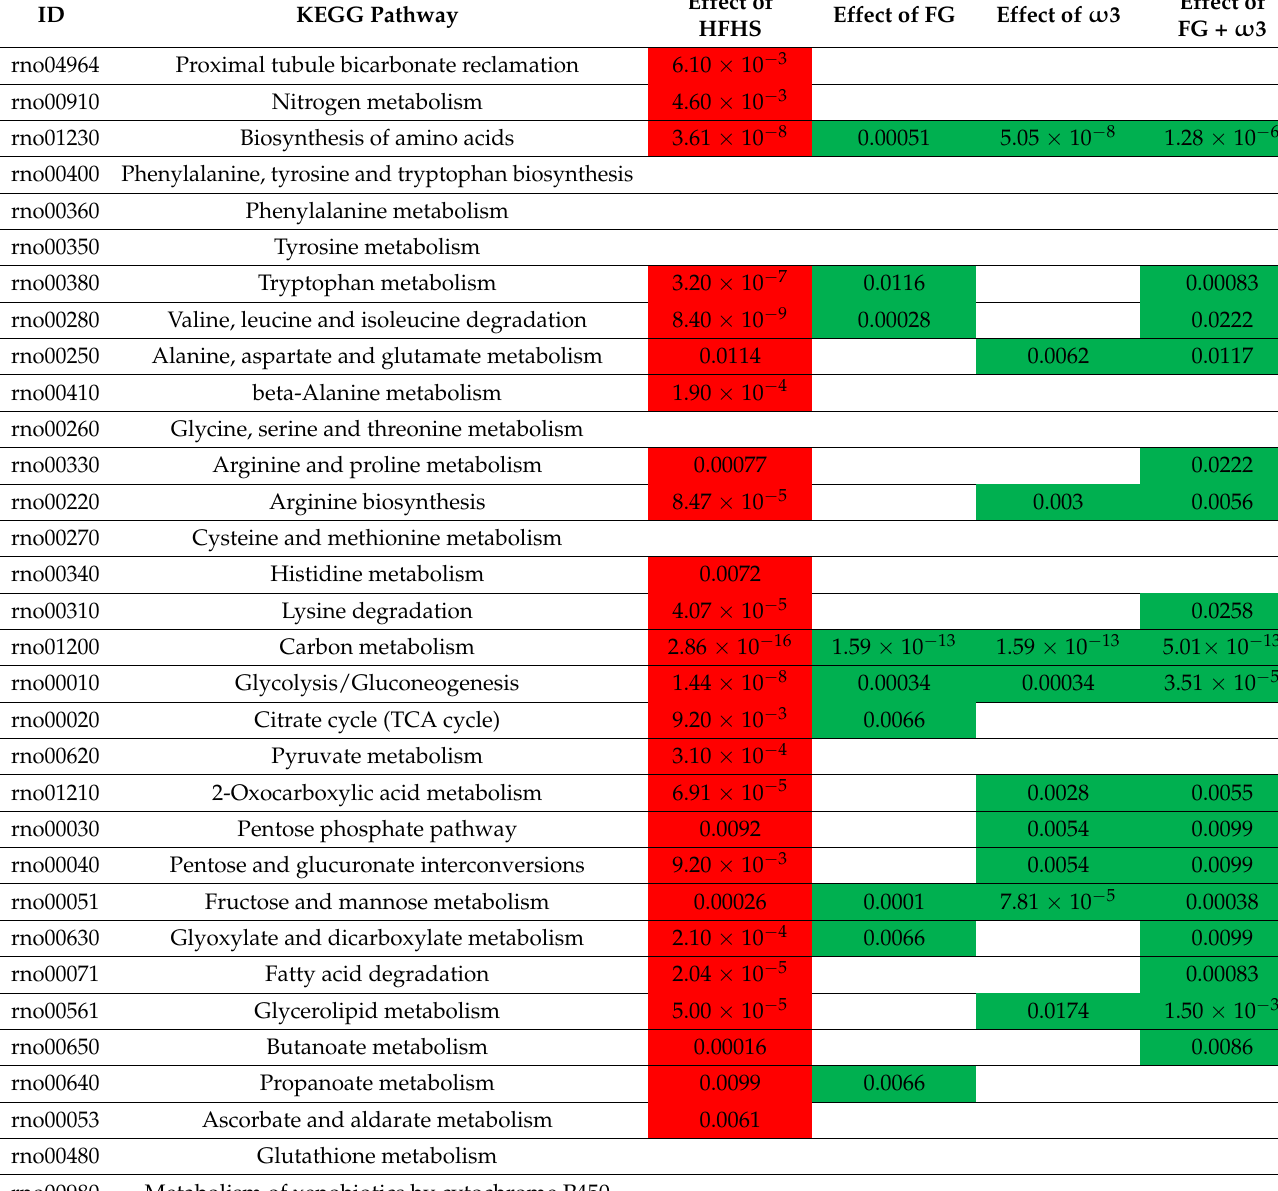
Table 6. KEGG pathway enrichment analysis for renal proteins was significantly more carbonylated due to the HFHS-diet intake compared to STD-diet (red), and for renal proteins, the analysis was significantly less carbonylated due to the supplementation of the HFHS diet with FG, fish oil, and both (green) 1